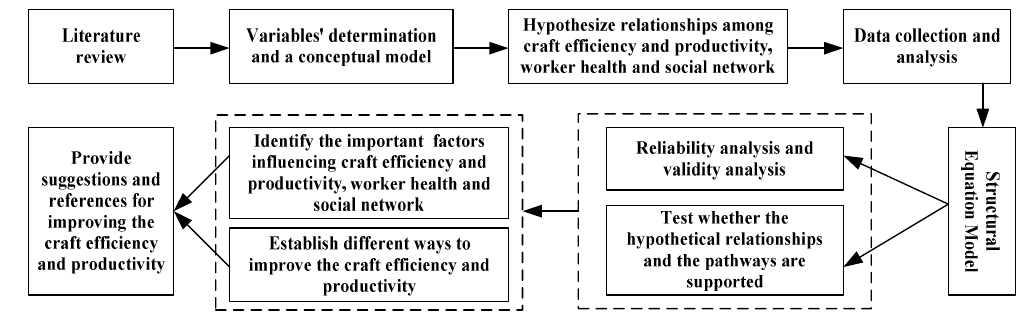
Figure 2. The research methodology.